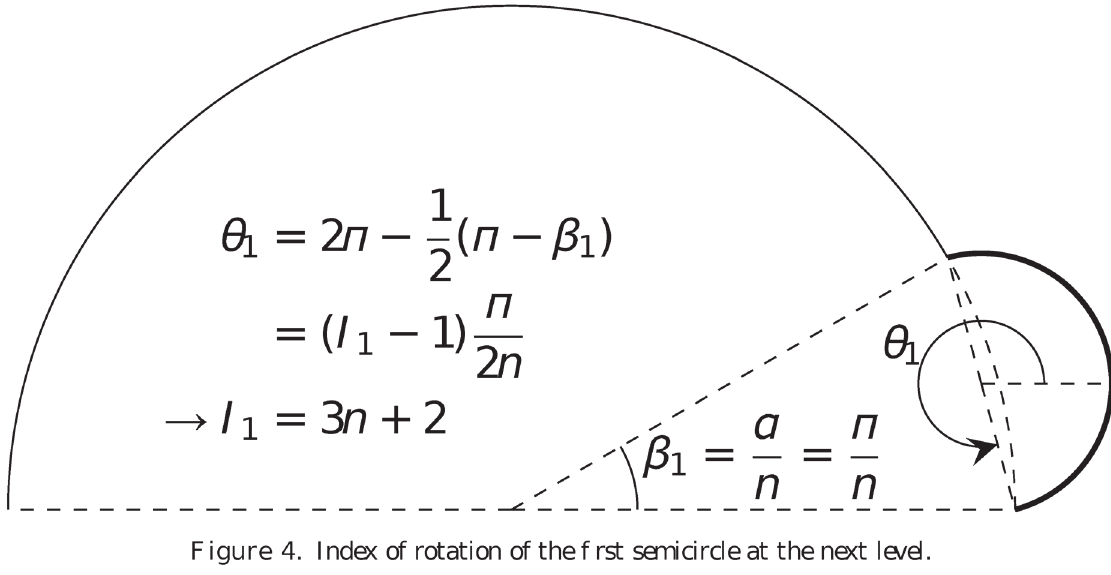
Fig 4. Index of rotation of the first semicircle at the next level. doi:10.1371/journal.pone.0117365.g004 Table 1. Indices of rotation of semicircles in the next level (arising from a semicircle of index I = 1). Index I of